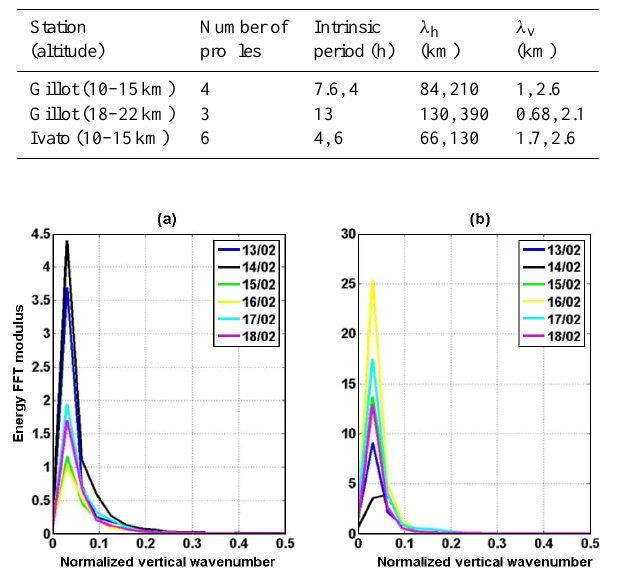
Fig. 6. Fast Fourier transform spectra of 70 GPS RO temperature perturbations from 13 February to 18 February 2008 in (a) the UT and (b) the LS ( λ v =100m/normalized